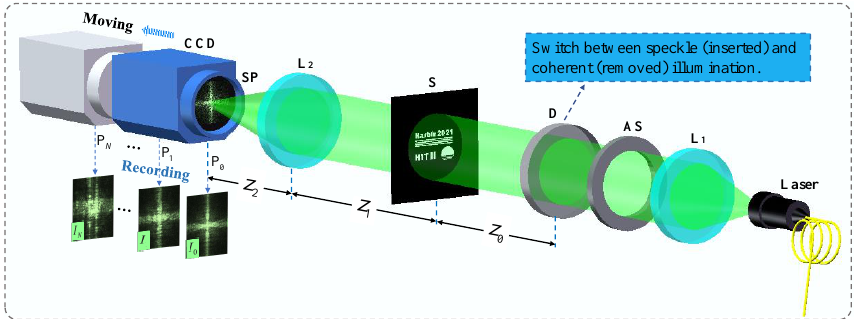
Figure 1. An optical setup for single-lens CDI with coherent and speckle illumination. AS: aperture stop; L 1 , L 2 : lens; D: diffuser; S: sample; SP: sensor